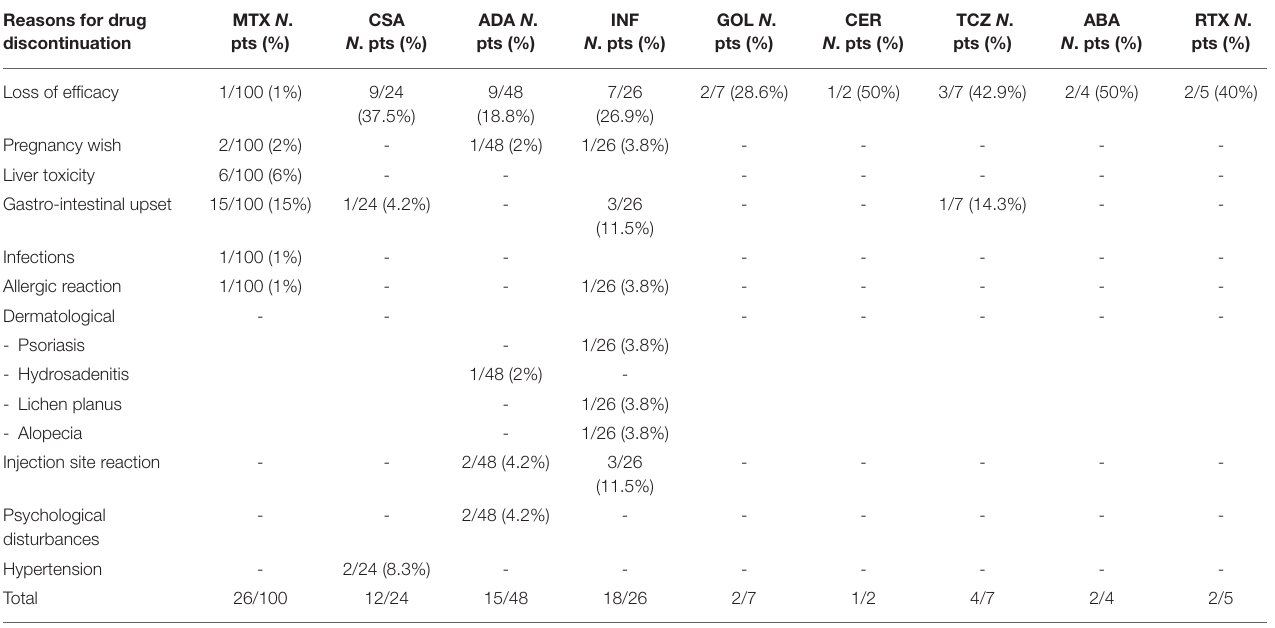
TABLE 3 | Drug-related reasons for drug discontinuation. Reasons for drug